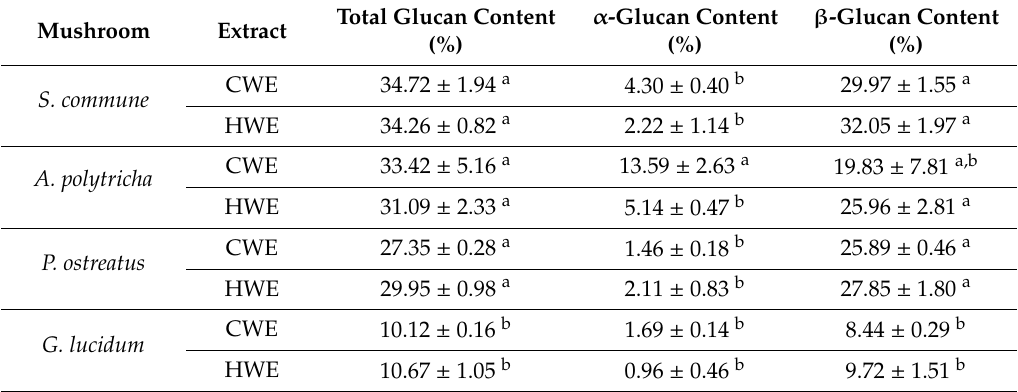
Table 2. Total glucan, α -glucan and β -glucan content of extracts from multiple types of mushroom.